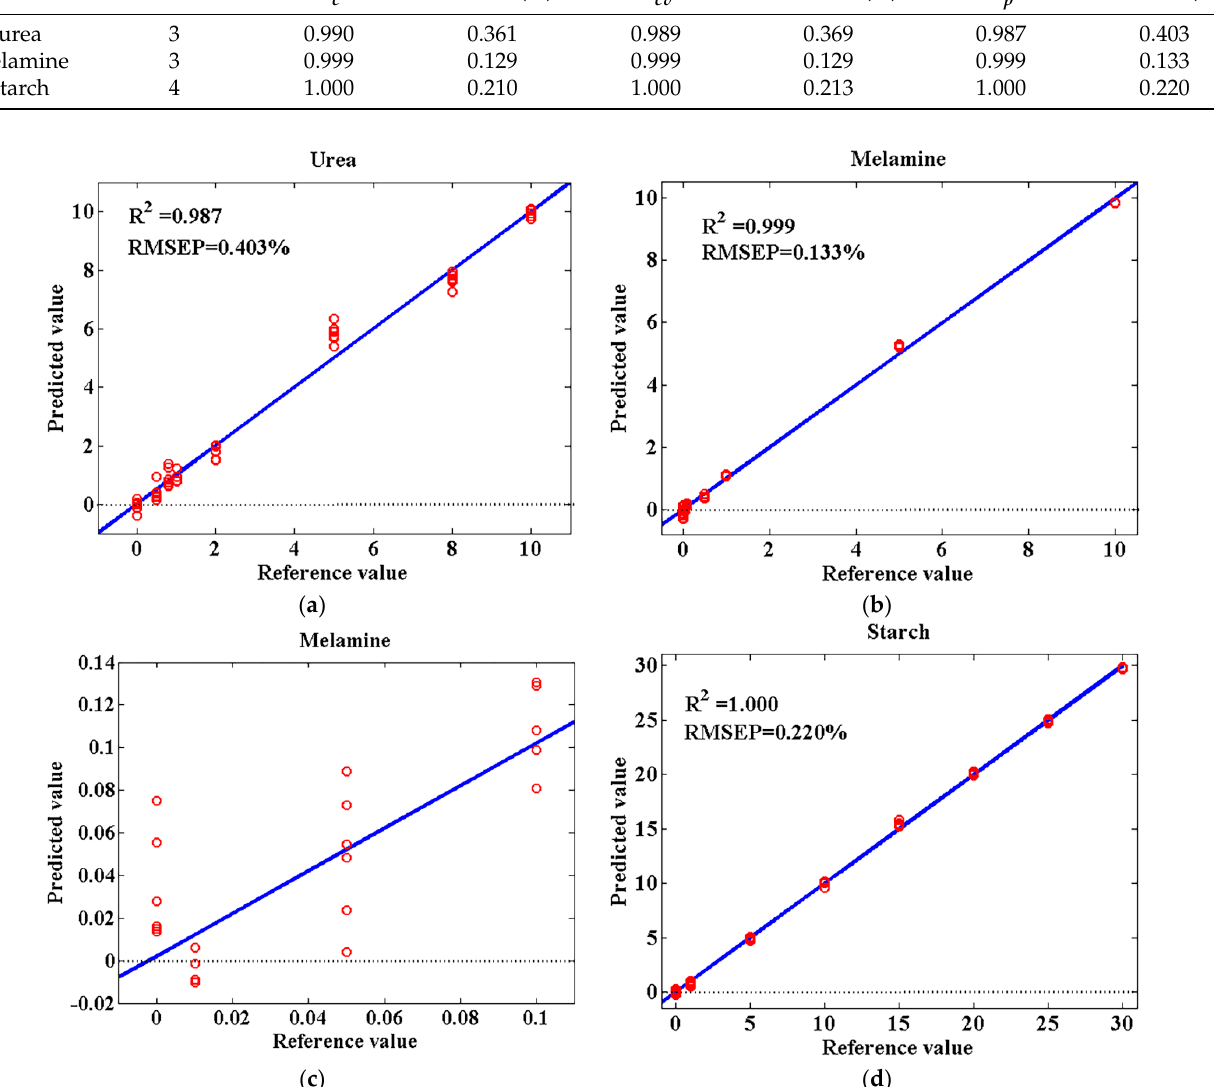
Figure 6. Predicted vs. reference plots for the prediction sets of the three multispectral PLS1 models for urea determination ( a ), melamine determination ( b ) with an enlarged view in range of 0–0.1% ( c ), and starch determination ( d